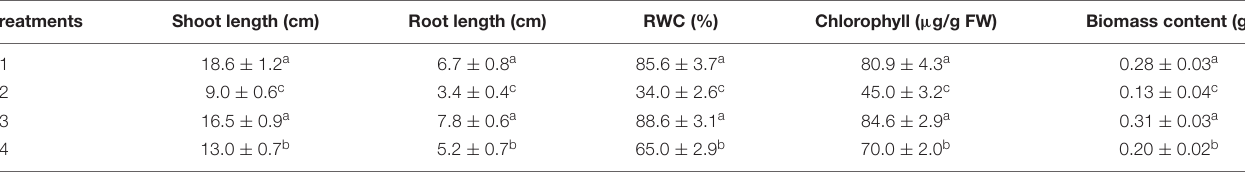
TABLE 2 | Effect of bacterial (BHU-AV3) inoculation on tomato plant growth parameters under salt stress conditions. Treatments Shoot length (cm)